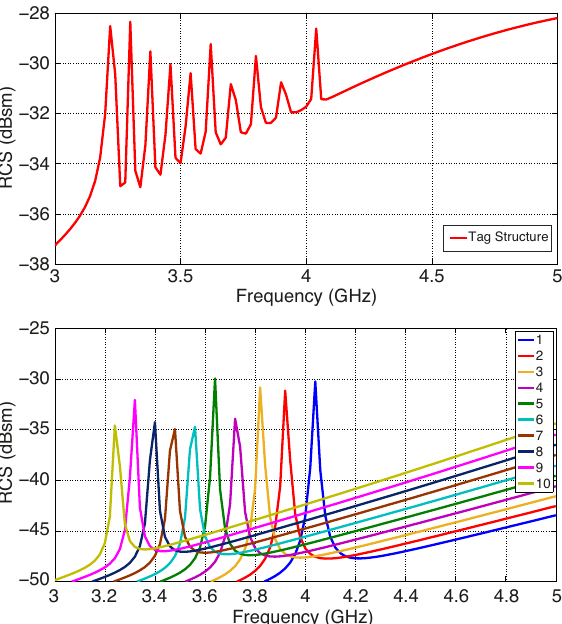
Figure 2: Electromagnetic response of the tag structure in Fig. 1, as well as the isolated characteristics of each res- onator. The backscattered RCS is plotted with respect to frequency from 3 . 0 GHz to 5 . 0